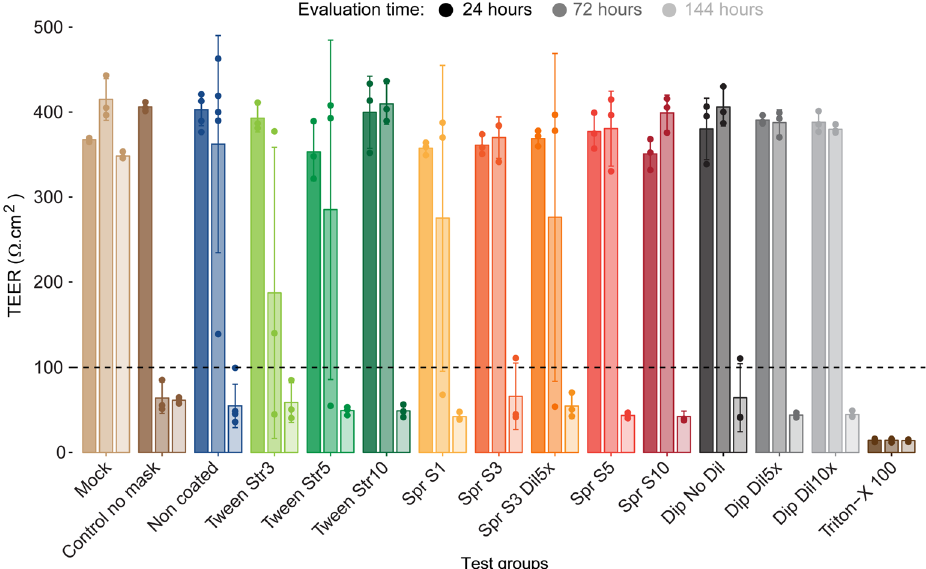
Figure 3. Transepithelial electrical resistance (TEER) measurements in MUCILAIR epithelia at 24, 72, and 144 h post infection. Means ± standard errors are shown; n = 3 in all treatments, except for non-coated samples (n = 5). The dotted line represents the 100 Ω·cm 2 limit of tissue integrity. Mock, non-infected non-treated control culture; Triton X-100 detergent used as a positive